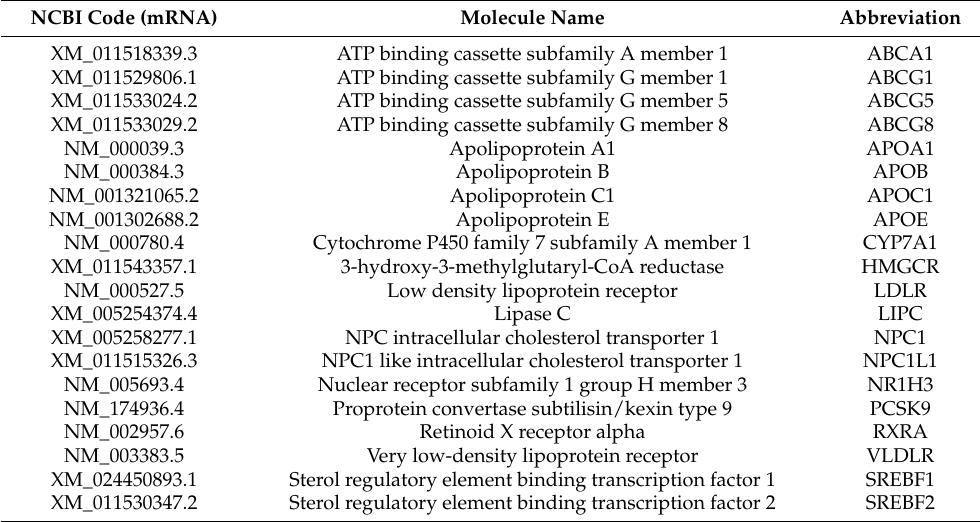
Table 2. Molecules associated with human cholesterol